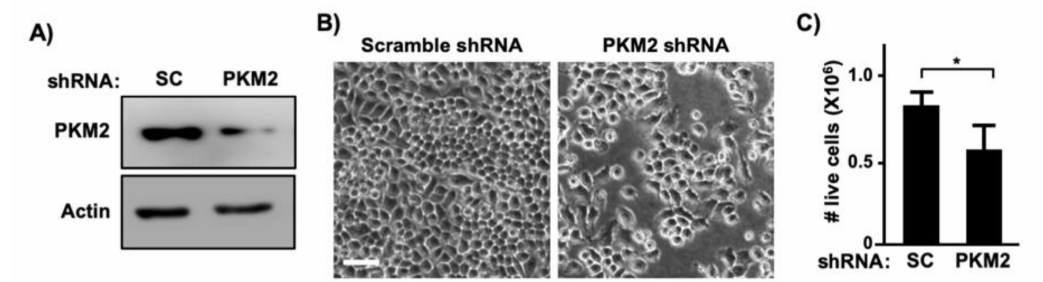
Figure 4. PKM2 is required for proliferation of cervical cancer cells. ( A ) SiHa cells were transiently transfected with scrambled (SC) shRNA or PKM2 shRNA vector. Total cell extracts were analyzed with western blot. ( B ) SiHa cells were transiently transfected as described in A and photographed 5 days later. Note that cells transfected with an PKM2 shRNA plasmid were sub-confluent. Scale bar, 100 µ m. ( C ) SiHa cells were transiently transfected as described in A and counted 5 days later. Data are presented as mean ± S.E.M. ( n = 3). * p = 0.01 (two-sided Student’s t